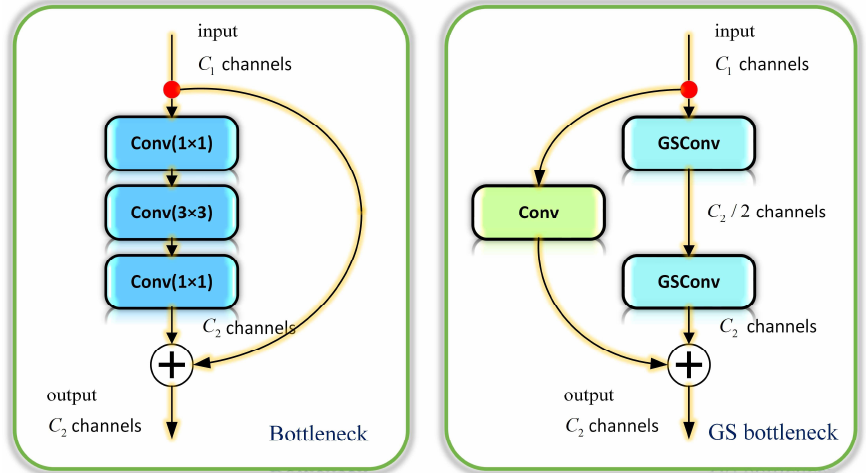
Figure 6. Structure of Bottleneck and GS bottleneck.